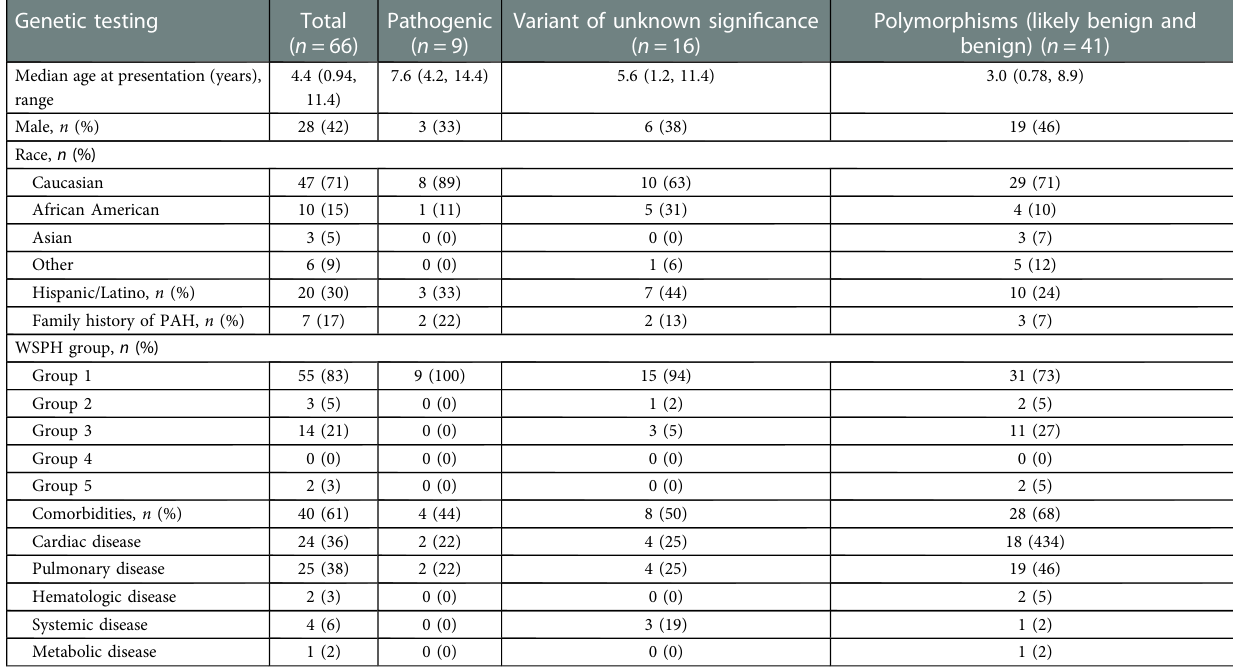
TABLE 1 Demographics of patients by genetic testing results. Genetic testing